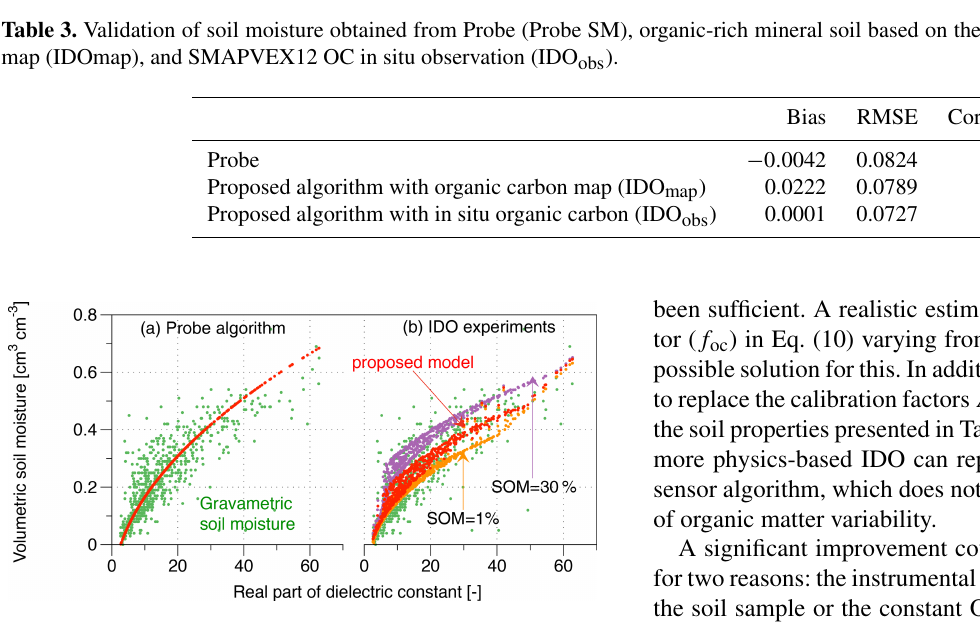
Figure 8. Investigation of the similarity of the scatter pattern be- tween the measured dielectric constant and the soil moisture: (a) ob- tained from the gravimetric measurements and (b) experimentally simulated with extreme SOM from 0% to